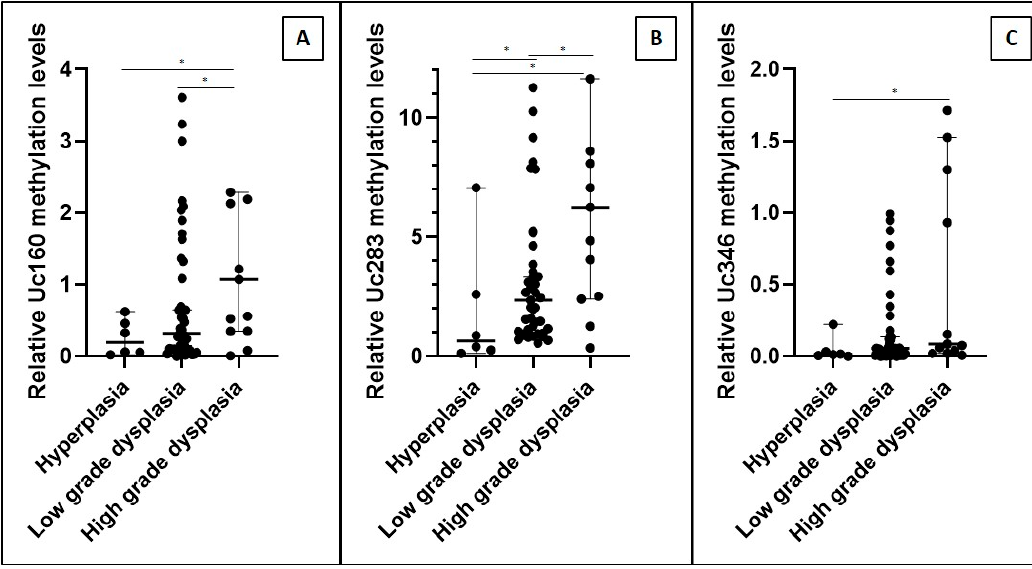
Figure 2. Relative tissue methylation levels of Uc160 ( A ), Uc283 ( B ), and Uc346 ( C ) in hyperplastic polyps and adenomas regarding the grade of dysplasia (median values with 95% CI). * p <